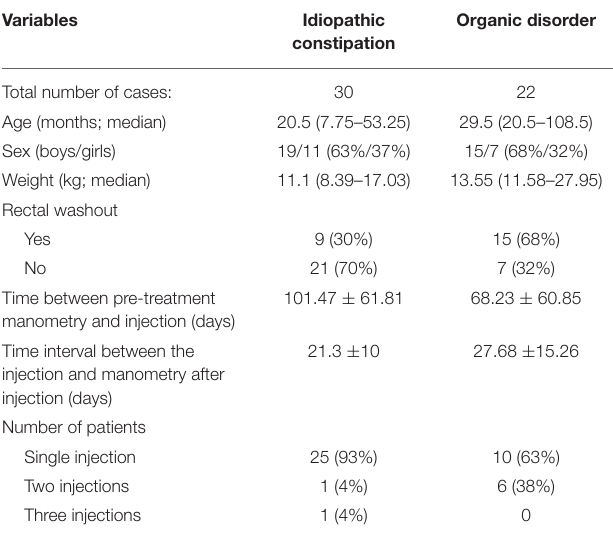
TABLE 1 | Clinical characteristics of cases included in this